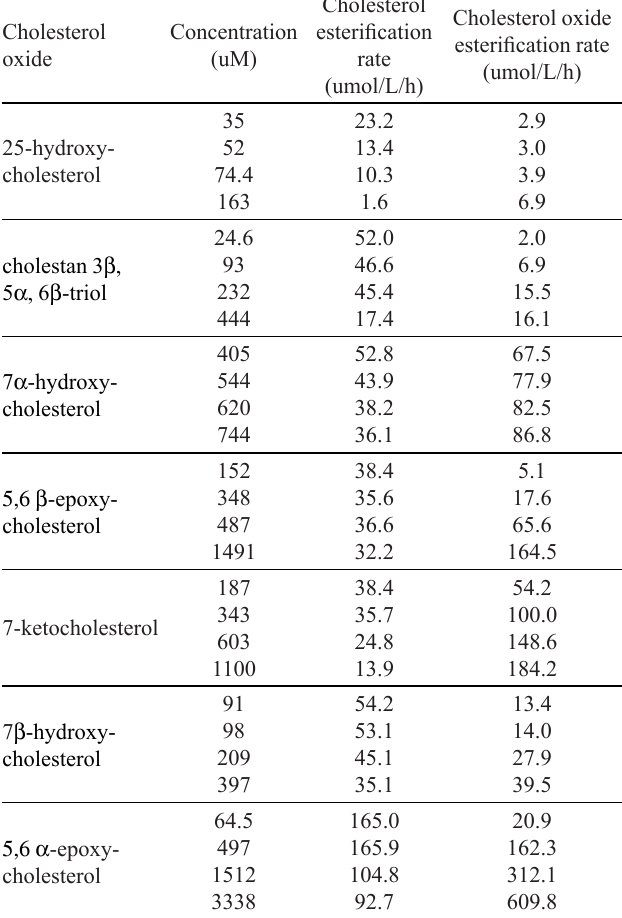
TABLE II - Dependence of cholesterol and cholesterol oxide esterification rate on cholesterol oxide concentration